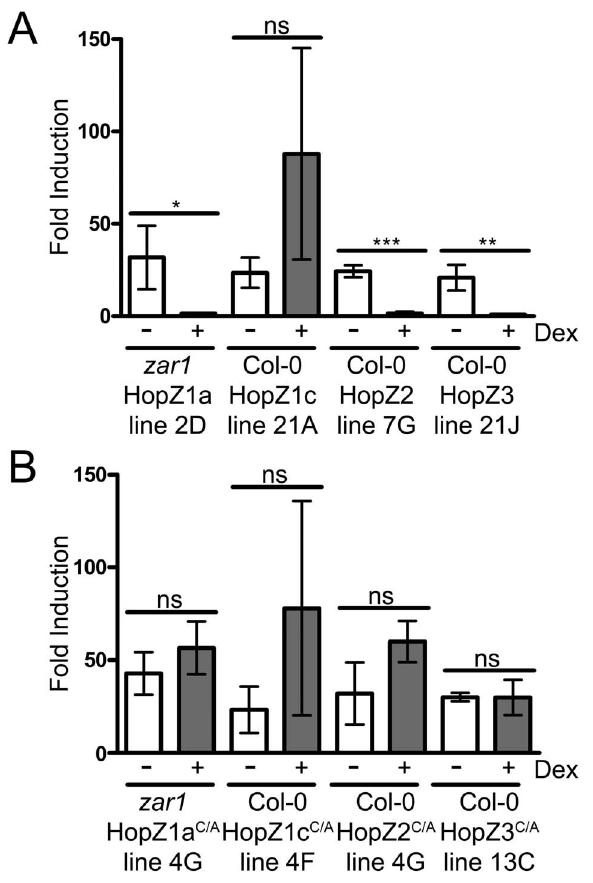
Fig. 4. HopZ family members differentially suppress ROS production. Transgenic HopZ 4 week-old plants were induced with 30 m M dexamethasone or mock treated with water 24 hours before sampling tissue. Tissue was treated with 2 m M flg22 44 hours after dexamethasone induction. ROS production was measured using a luminol-dependent chemiluminescence assay. Luminescence was measured for a total of 100 seconds over a 50 minute period from 3 plants per treatment. Each flg22-treated sample was normalized with the paired water treated sample to give a fold induction. Two-tailed homoschedastic t-tests were performed to test for significant differences. Within a plant genotype, dexamethasone induced plants were compared to non-induced plants and significant differences are indicated by an asterisk (* P , 0.05, ** P , 0.01, *** P , 0.001, ns 5 not significant). Error bars indicate the standard deviation from the mean. Similar results in observed in two experiments. (A) Transgenic HopZ lines in zar1 (HopZ1a) or Col-0 (HopZ1c, HopZ2, HopZ3) backgrounds. (B) Transgenic catalytically inactive HopZ C/A lines in zar1 (HopZ1a C/A ) or Col-0 (HopZ1c C/A , HopZ2 C/A , HopZ3 C/A )